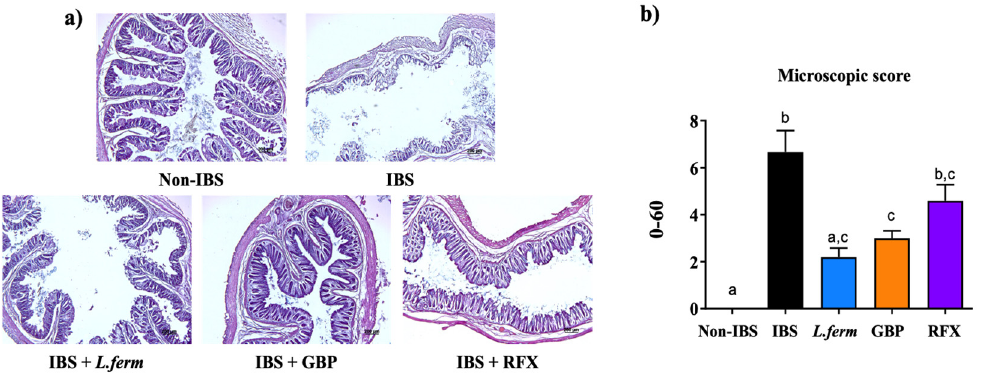
Figure 7. Effects of DCA vehicle (Non-IBS), 4 mmol/L DCA (IBS), L. fermentum (10 9 CFU) ( L. ferm ), Gabapentin at 70 mg/kg (GBP) and Rifaximin at 150 mg/kg (RFX) administration on colonic tissue. ( a ) Representative sections of the distal colon analyzed by hematoxylin and eosin staining (scale bar = 20 μ m). ( b ) Histopathological scores of inflammation cell infiltration, depth of lesions, destruction of crypts, width of lesions and crypt damage. Data are expressed as means ± SEM ( n = 10). Groups with different letters statistically differ ( p < 0.05).